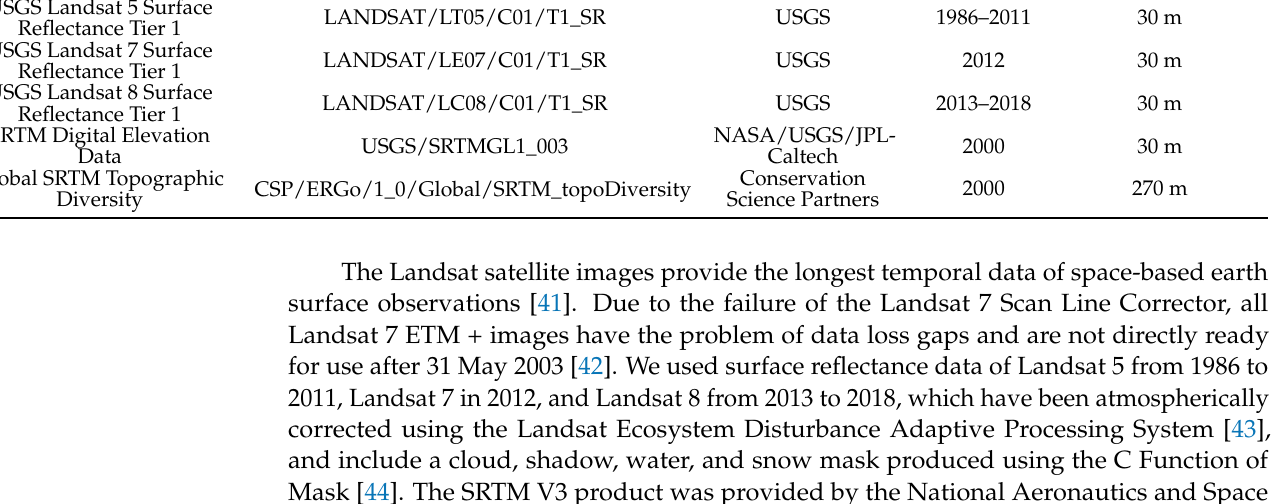
Table 1. Datasets used in this study. All are available on the GEE platform. USGS represent United States Geological Survey.